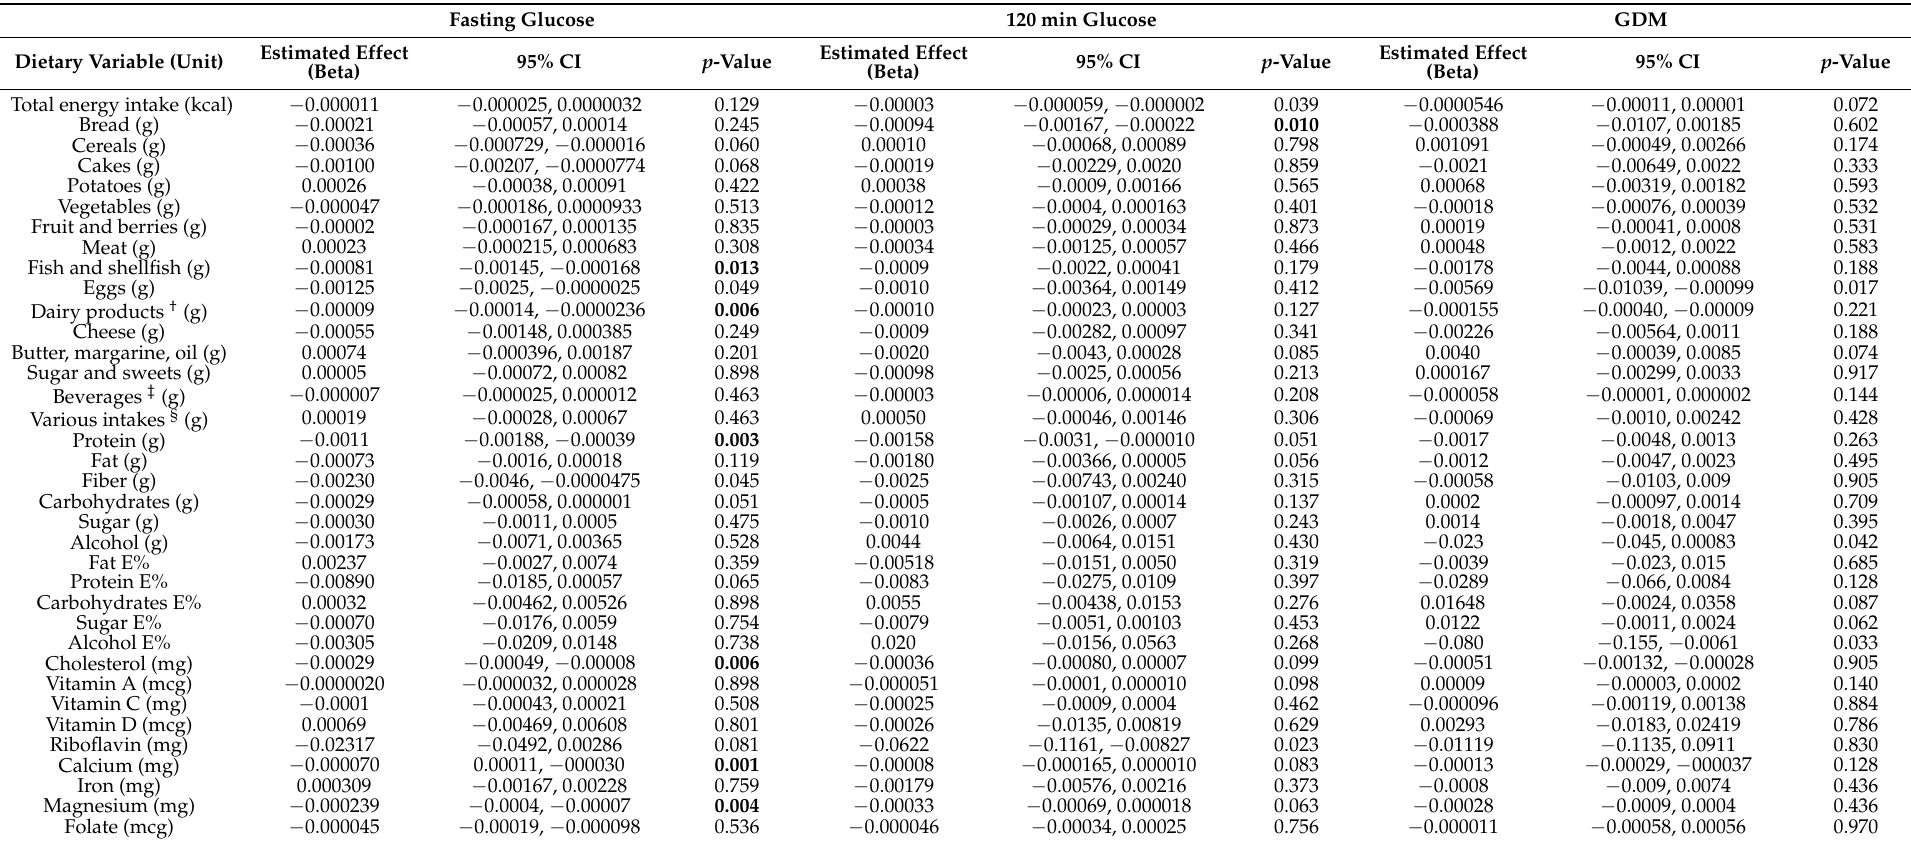
Table 2. Associations between early pregnancy dietary intake and fasting glucose, 120 min glucose, and GDM in late pregnancy. Results from univariate analysis are presented as estimated effect (beta), 95% CI, and p